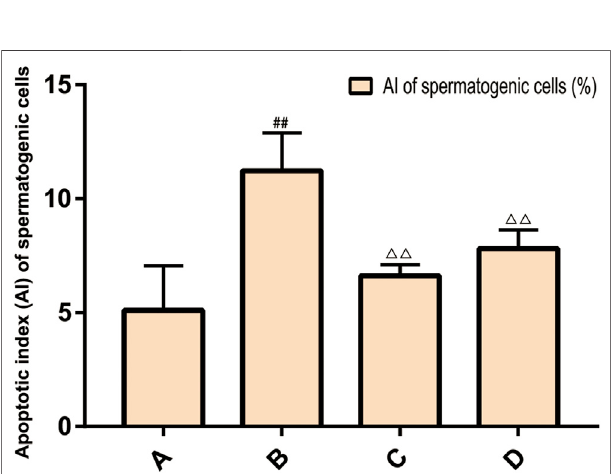
FIGURE 10 | The AI of spermatogenic cells. (A) : normal group; (B) : model group; (C) : ZBDHD group; (D) :positive control group. Compared with normal group ## p < 0.01; compared with model group, △△ p <